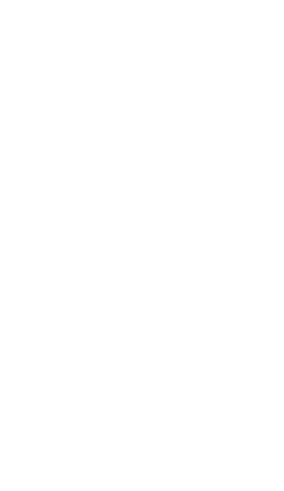
Table 6. The MBIC and MBEC values of temporin-PKE and its